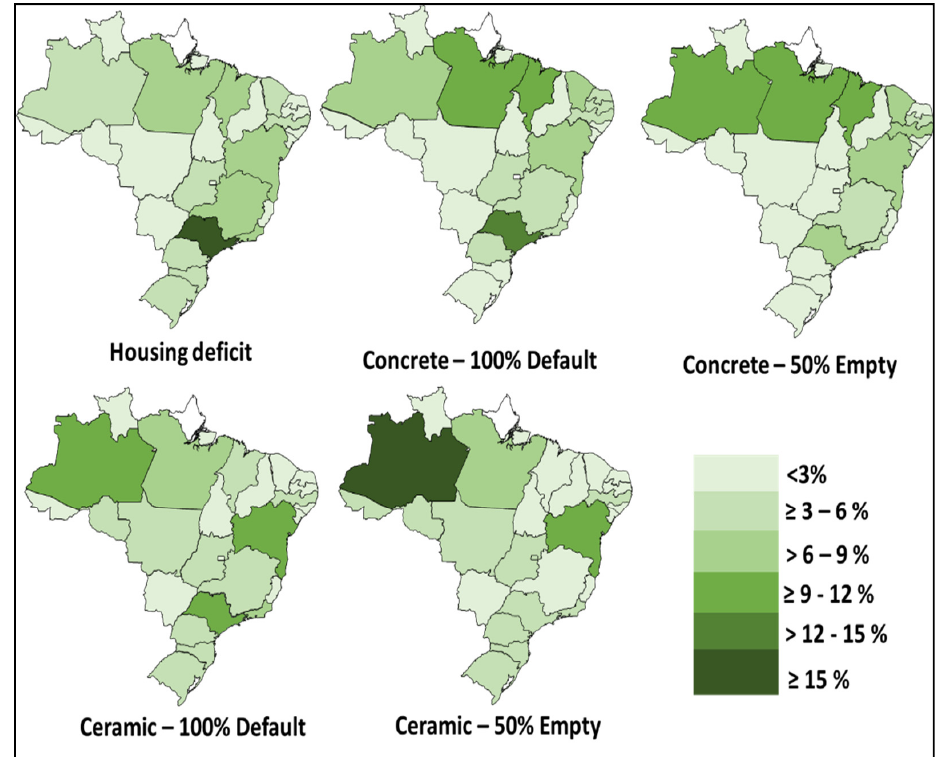
Figure 13. Percentage of the cumulative housing deficit in 2050 and CO 2 -eq emissions for each state considering each block type for the different transportation options; 100% Default—represents that the truck is loaded with 100% of its capacity and returns full; 50% empty—represents that the truck is loaded with 50% of its capacity and returns empty.